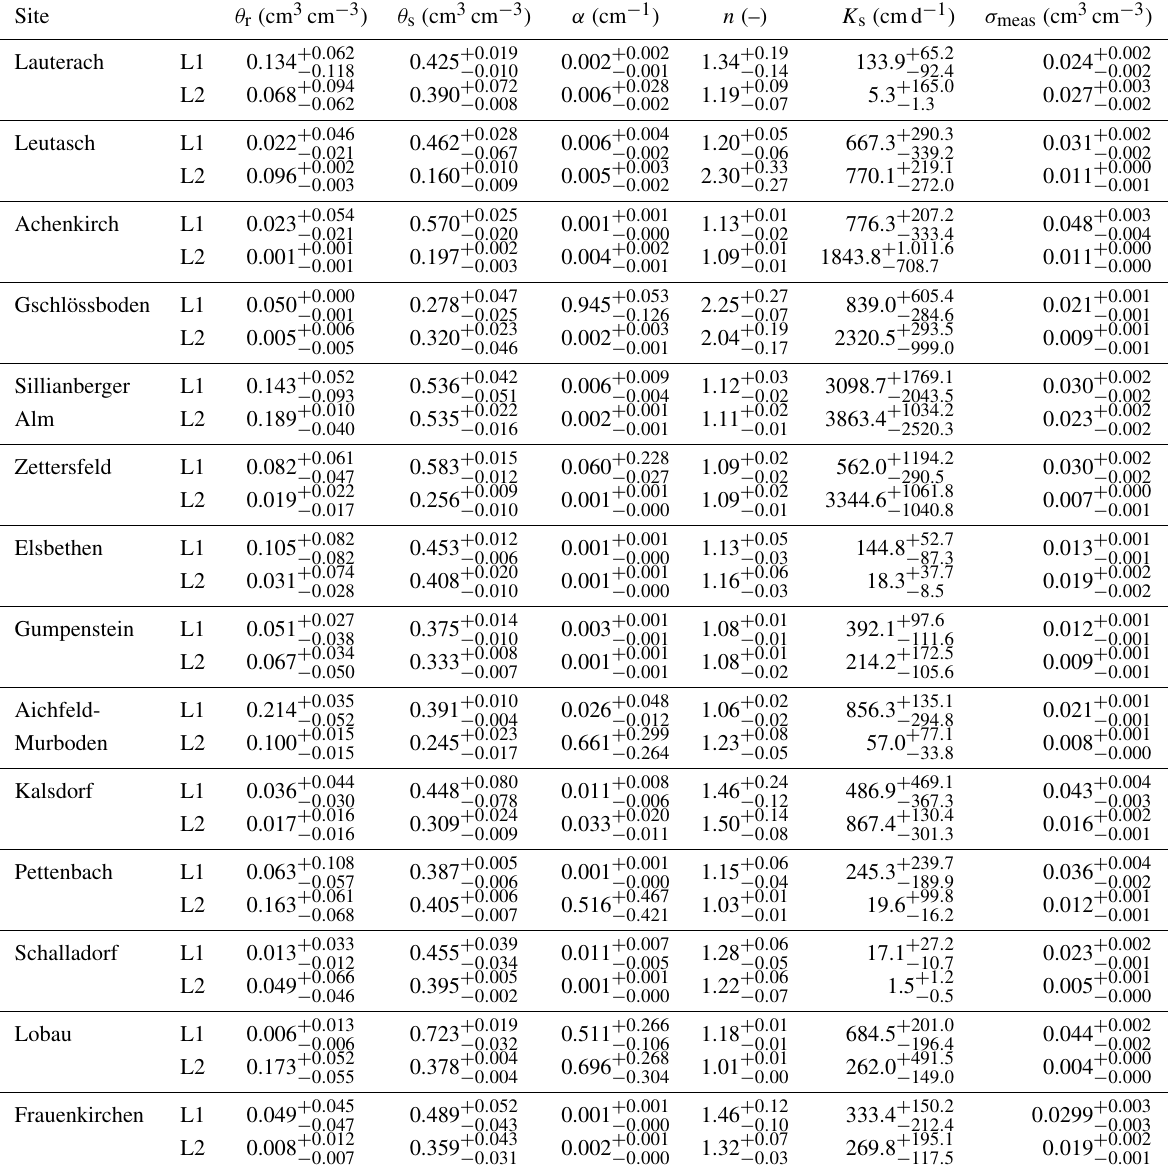
Table 1. Median estimates and the 95% credible interval of soil hydraulic parameters and measurement errors for the upper (L1) and lower (L2) soil